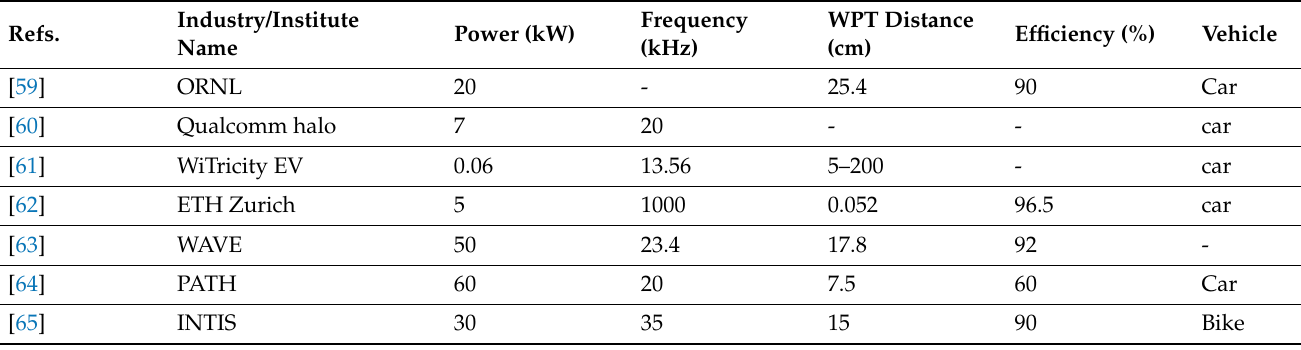
Table 4. Specification of various EV